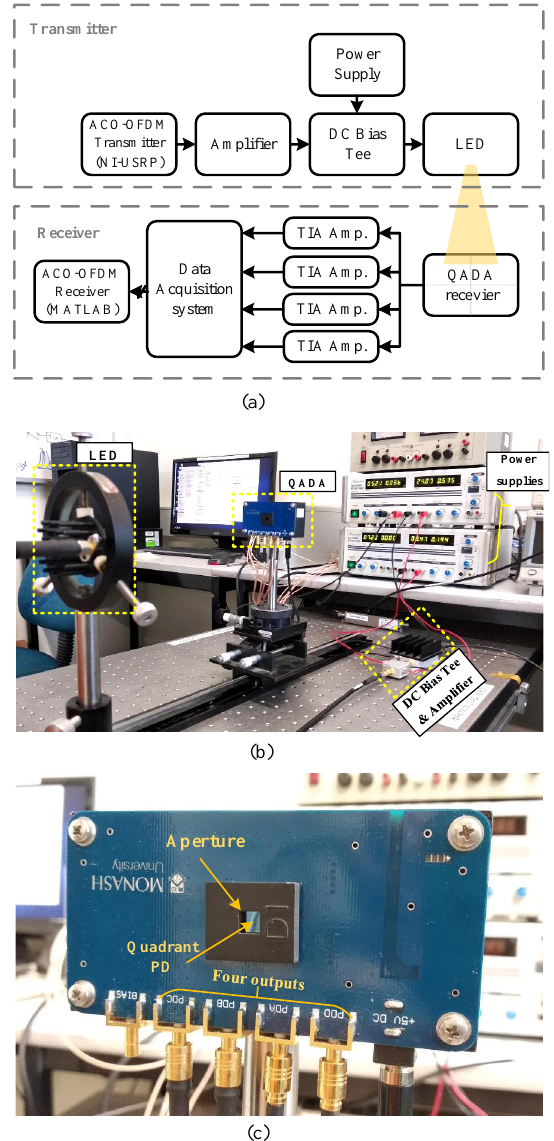
Figure 14. Experimental set-up ( a ) block diagram shows the experimental set-up; ( b ) photo of the experiment; ( c ) photo of the QADA